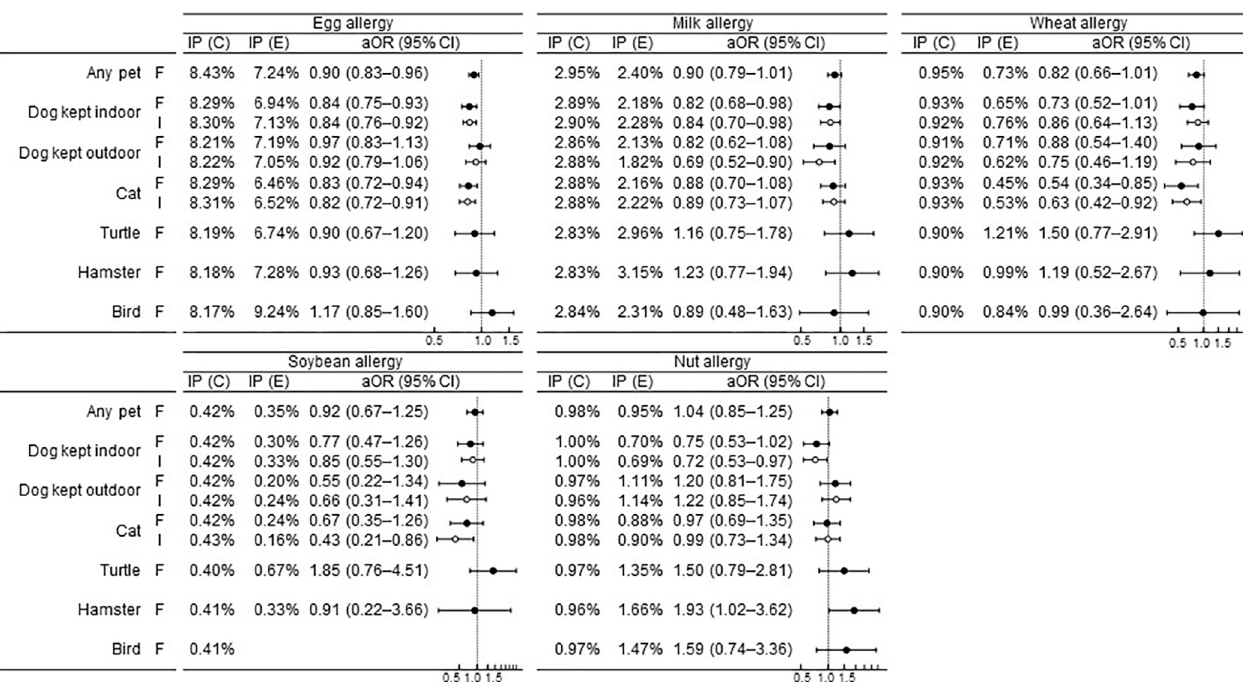
Fig 3. Association between pet exposure and the incidence risk of specific food allergies until 3 years of age. F, fetal (black circles); I, during early infancy (white circles); IP (C), incidence proportion (control); IP (E), incidence proportion (exposed); cOR, crude odds ratio; aOR, adjusted odds ratio; CI, confidence